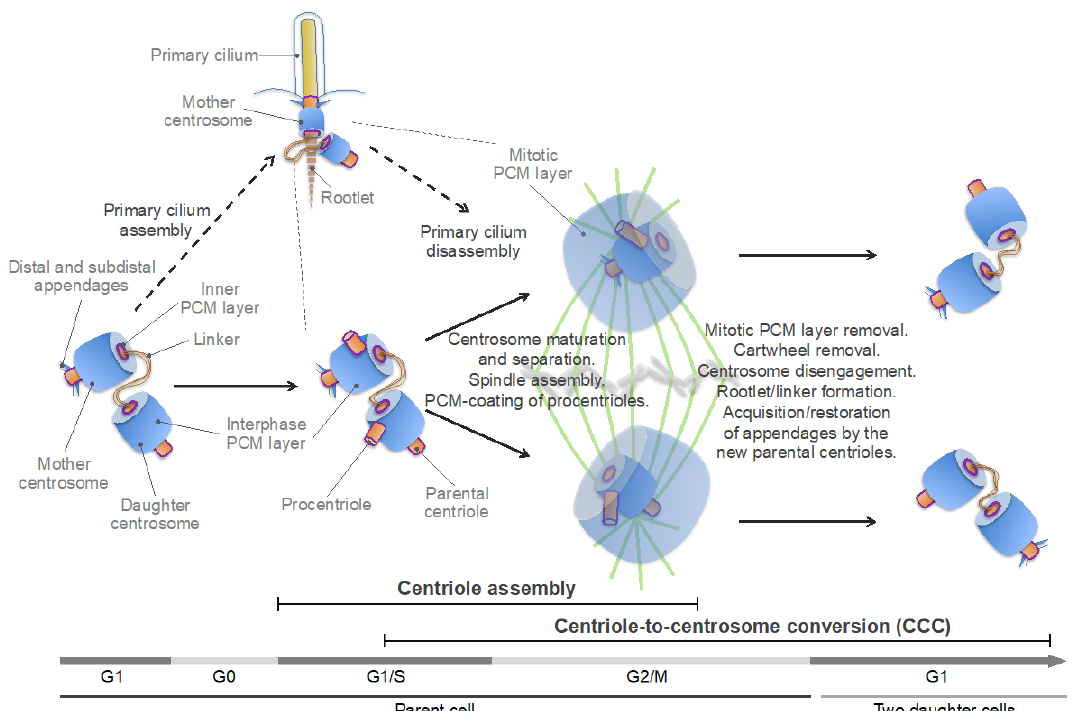
Figure 3. Schematic of the centrosome cycle. The inner (proximal to the centriole) pericentriolar material (PCM) layer, which contains centrosomal protein of 192 kDa (CEP192) and polo-like kinase 1 (PLK1), is highlighted by a purple line. See text for details.